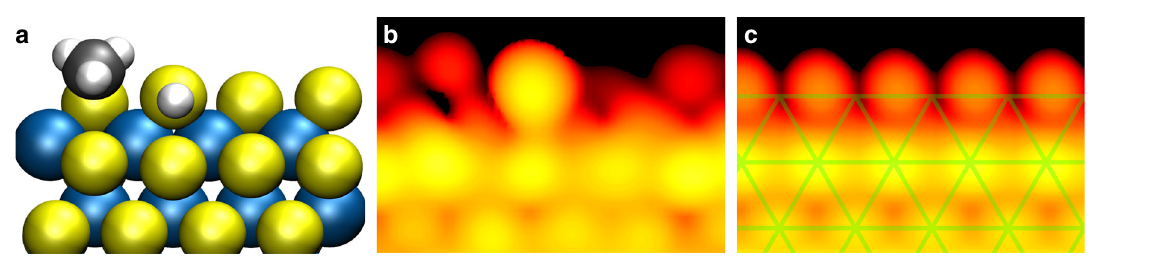
Fig. 4 Thermodynamically preferred structure under the experimental desulfurization conditions (P CH3SH = 0.1bar, P H2S = ~0.001bar, P H2 = 0.9bar, 250 °C). a Ball model. b Simulated STM image for U s = − 0.3 V, using an electron density contour value of 1 × 10 − 6 AU. c Simulated STM image taking into account thermal averaging due to diffusion, adsorption and desorption. The green grid highlights the registry shift of the edge atoms with respect to the basal plane S atoms, which was also observed in the experiment NATURE COMMUNICATIONS| (2019) 10:2546